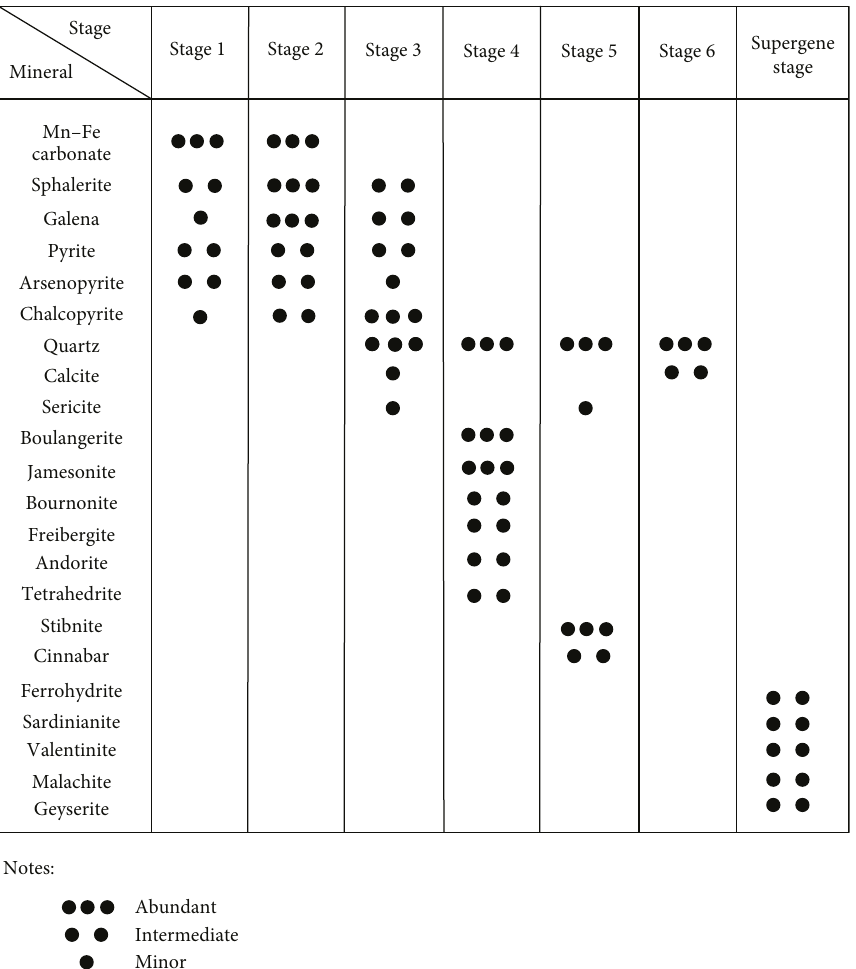
Figure 7: Ore paragenetic sequence within the Keyue Sb – Pb – Zn – Ag